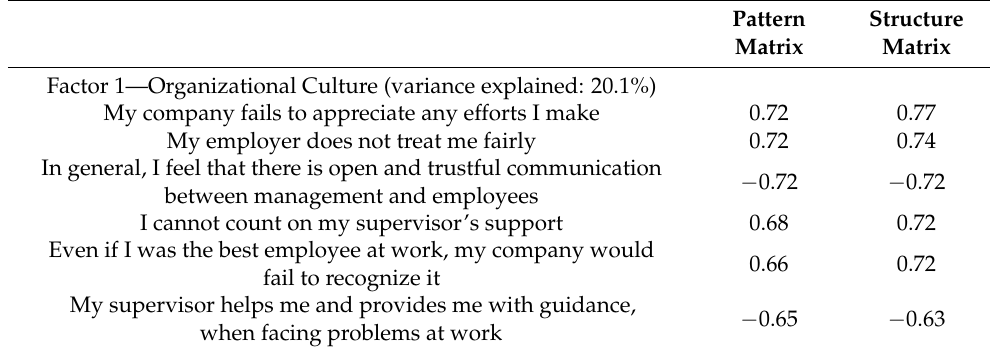
Pattern Structure Matrix Matrix